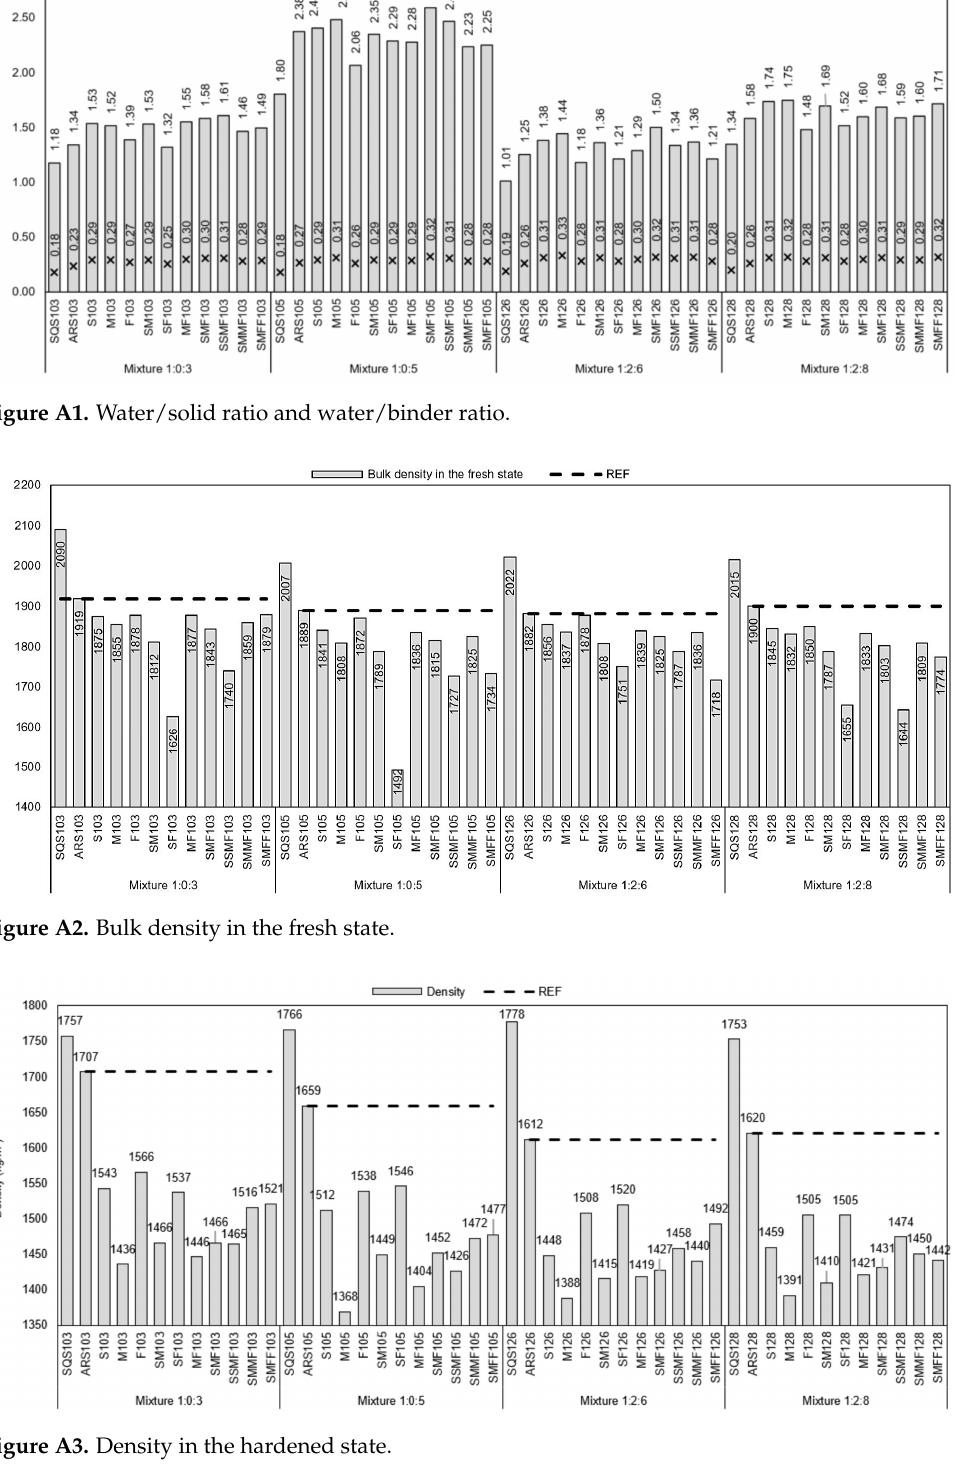
Figure A3. Density in the hardened